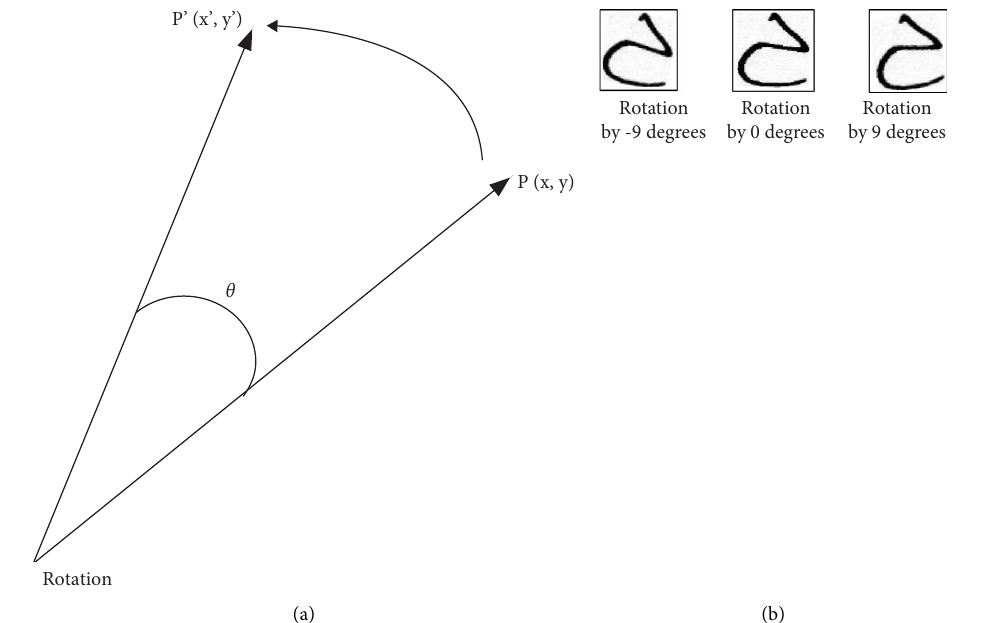
Figure 4: (a) Process of rotation technique. (b) Example of rotated images of the number nine. Table 4: Efect of rotation on performance, where r is the angle in degrees describing the amount of rotation. NITROHCSv1.0 Odia character database ISI image Odia numeral database Model